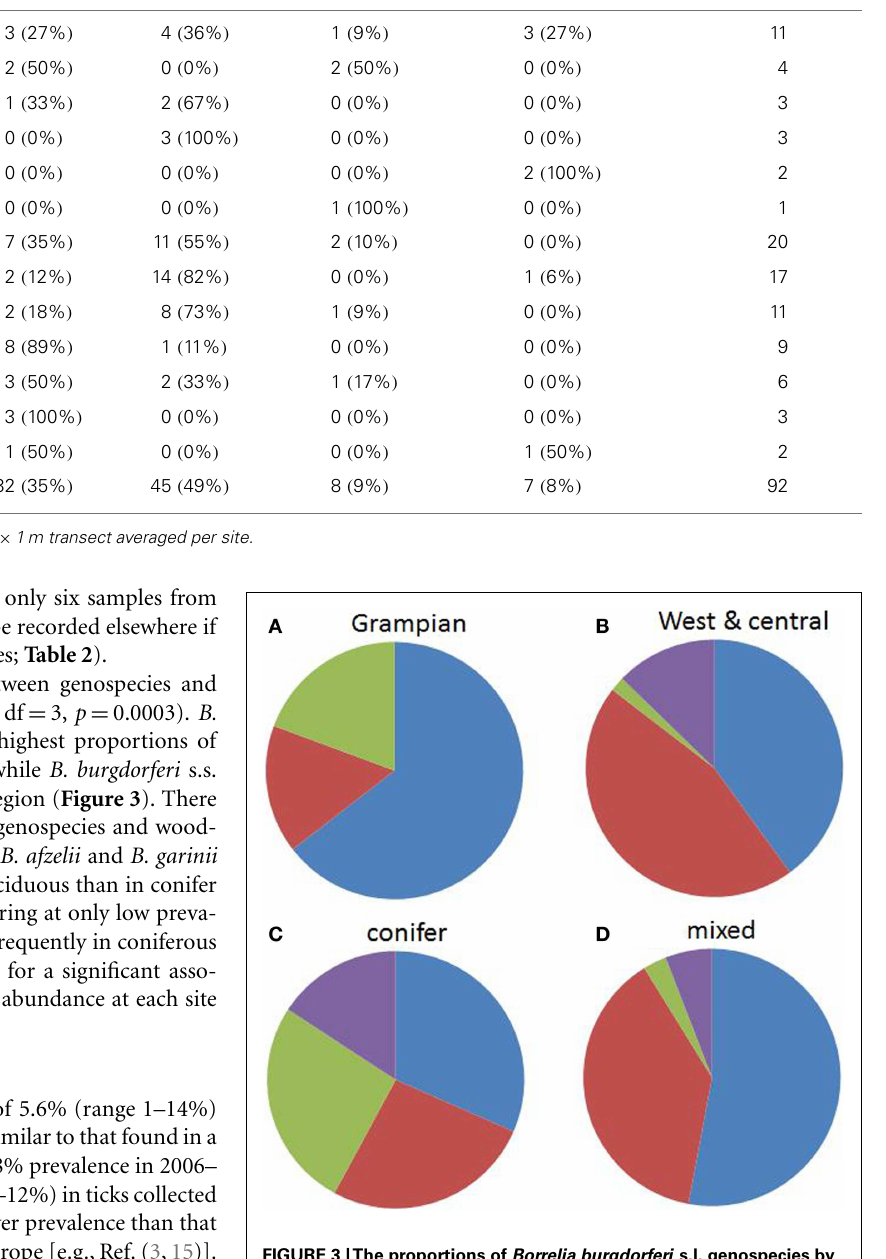
FIGURE 3 |The proportions of Borrelia burgdorferi s.l. genospecies by area: (A) west and central Scotland and (B) the Grampian Region of Scotland (the Northeast and the Cairngorms) and by habitat: (C) conifer forest and (D) mixed/deciduous woodlands, averaged over 13 (6 coniferous, 7 mixed/deciduous) sites across Scotland. Blue = B. afzelii , red = B. garinii, purple = B. valaisiana , and green = B. burgdorferi s.s.